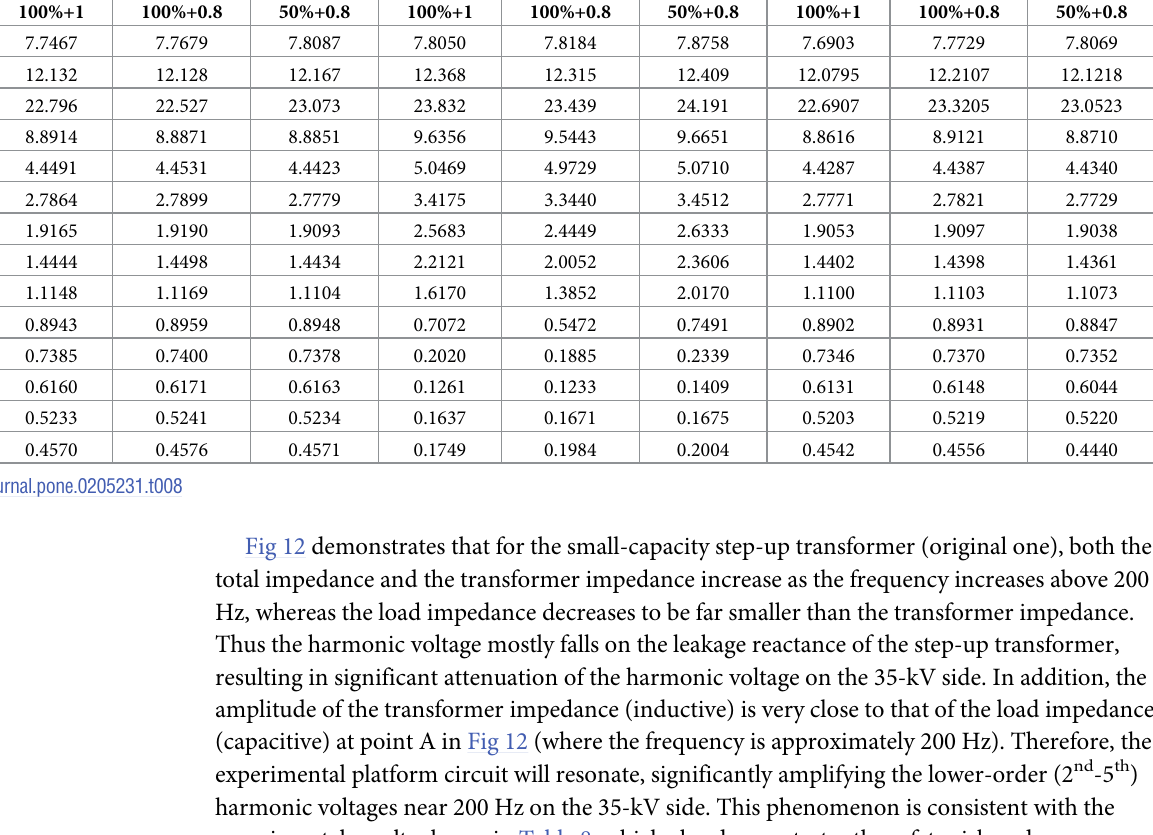
former. In comparison, when applying a step-up transformer with a capacity of 1000 kVA, the range investigated. The simulation results show that for this transformer, no harmonic voltage amplification or attenuation occurs on the 35-kV side. This finding indicates that the experi- mental platform with a large-capacity step-up transformer is feasible.